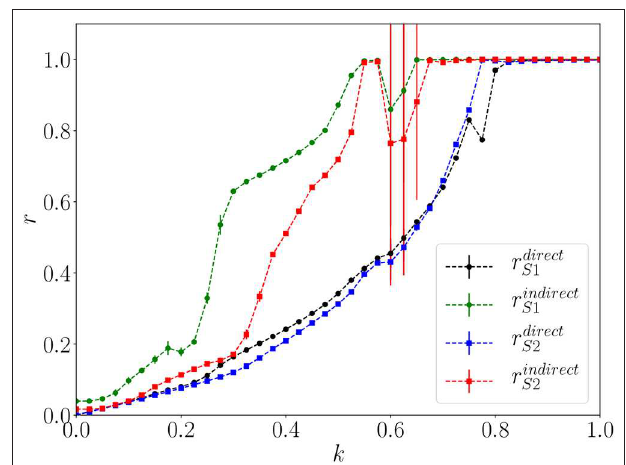
FIGURE 7 | Network 2. Mean and standard deviation of r direct (black circle) and r indirect (green circle) for Star 1 and r direct (blue square) and r indirect (red square) for Star 2 as a function of the coupling k